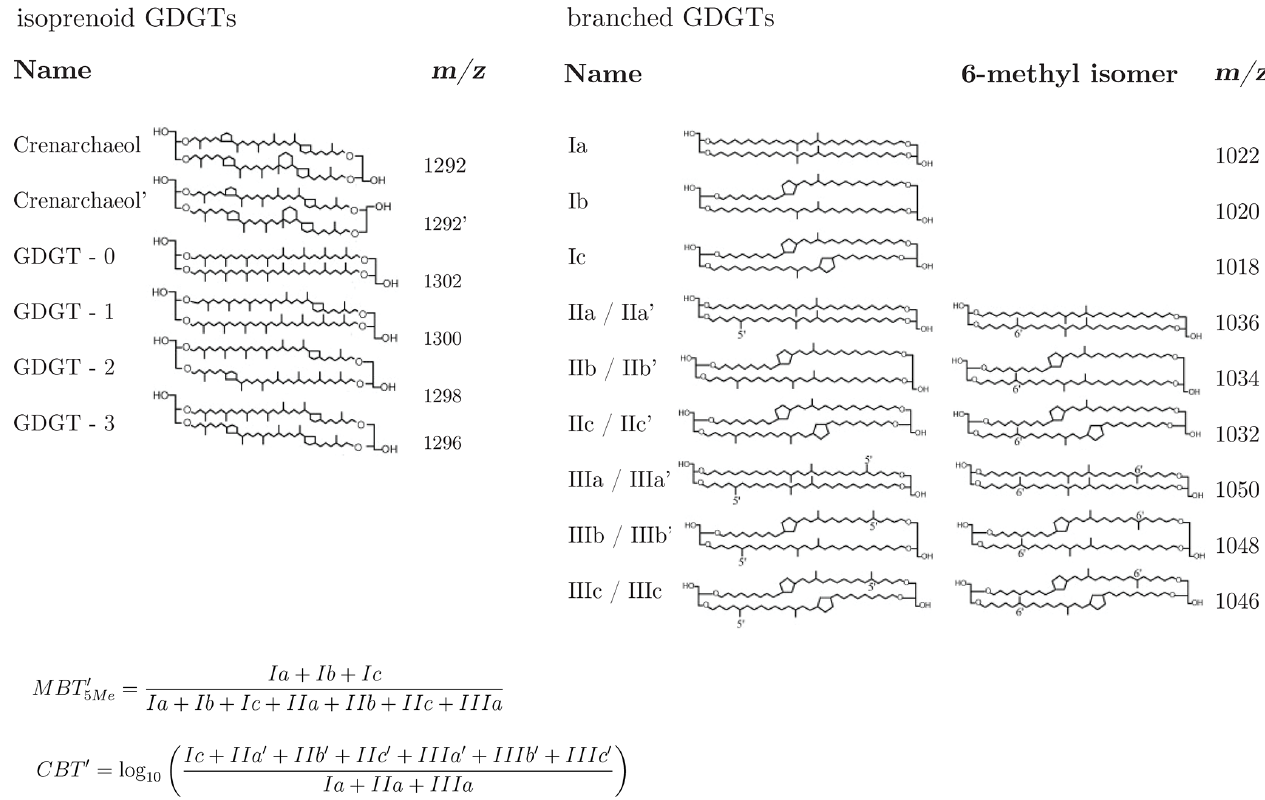
Figure A1. Molecular structures of GDGTs analyzed in this study. The equations to determine the MBT (cid:48) from De Jonge et al.